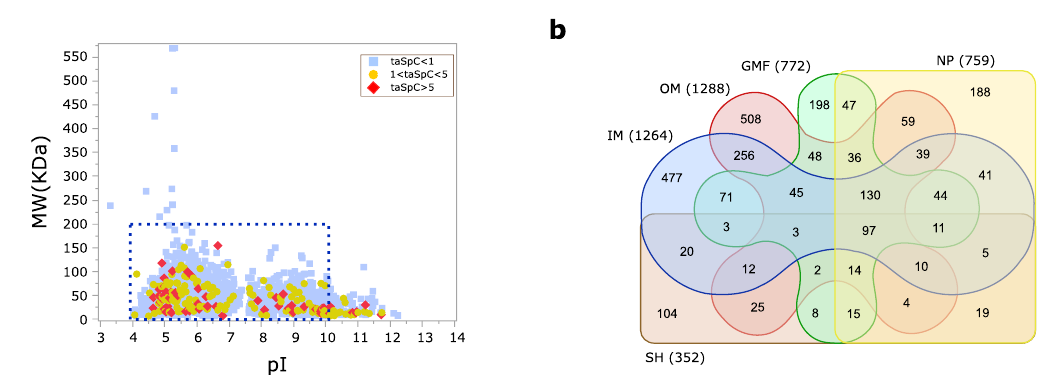
Figure 2. Multidimensional Protein Identification Technology (MudPIT) analysis of P. aeruginosa cell envelope. ( a ) Virtual 2D map of P. aeruginosa proteins identified by MudPIT approach ( n = 2539 proteins). Light blue/square indicates proteins identified by a total average SpC ≤ 1, yellow/circle proteins by a total average SpC in the range 1–5, while red/rhombus proteins by a total average SpC ≥ 5. The blue box corresponds to the typical pI and MW ranges of 2D gel analysis. ( b ) Venn diagrams reporting the distribution of proteins identified following IM (Inner Membrane), OM (Outer Membrane), GFP (Global Membrane Fraction), SH (Shaving) and NP (Nanoparticles) extraction